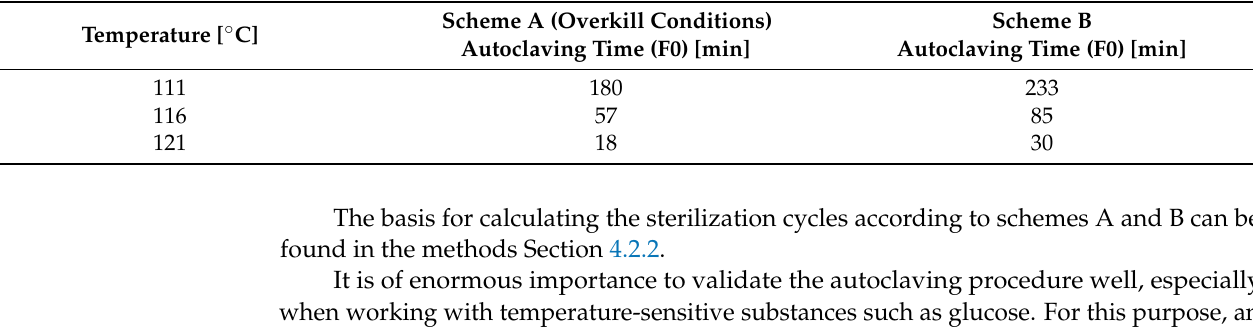
Table 1. Autoclaving schemes A/B.